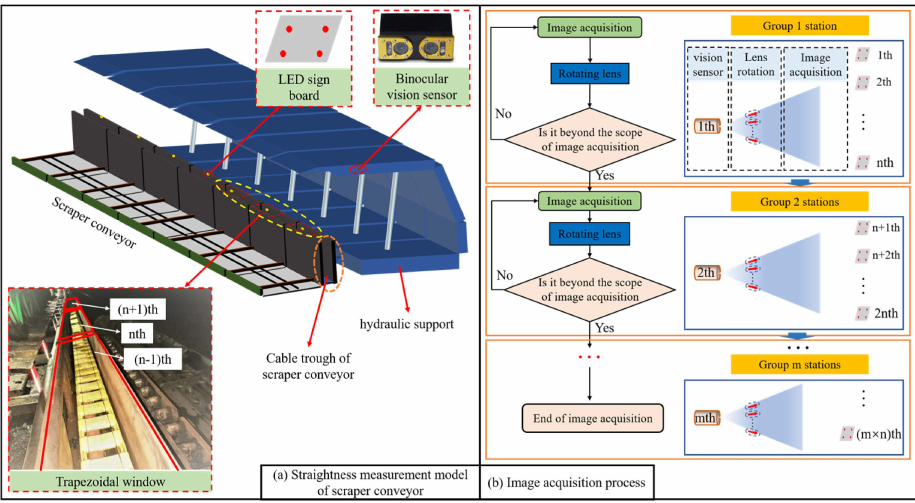
Figure 2. Scraper conveyor visual contact force measurement